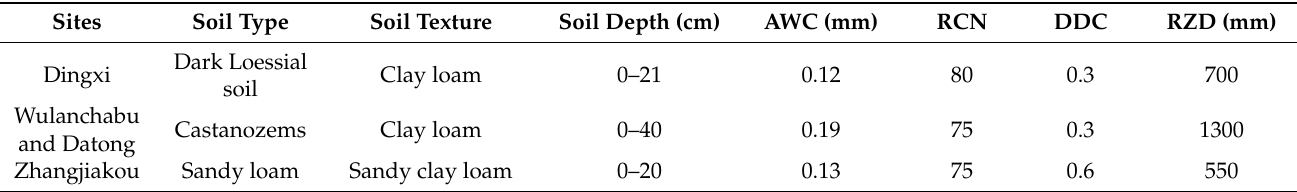
Table 2. Soil variable indexes for the four field experimental